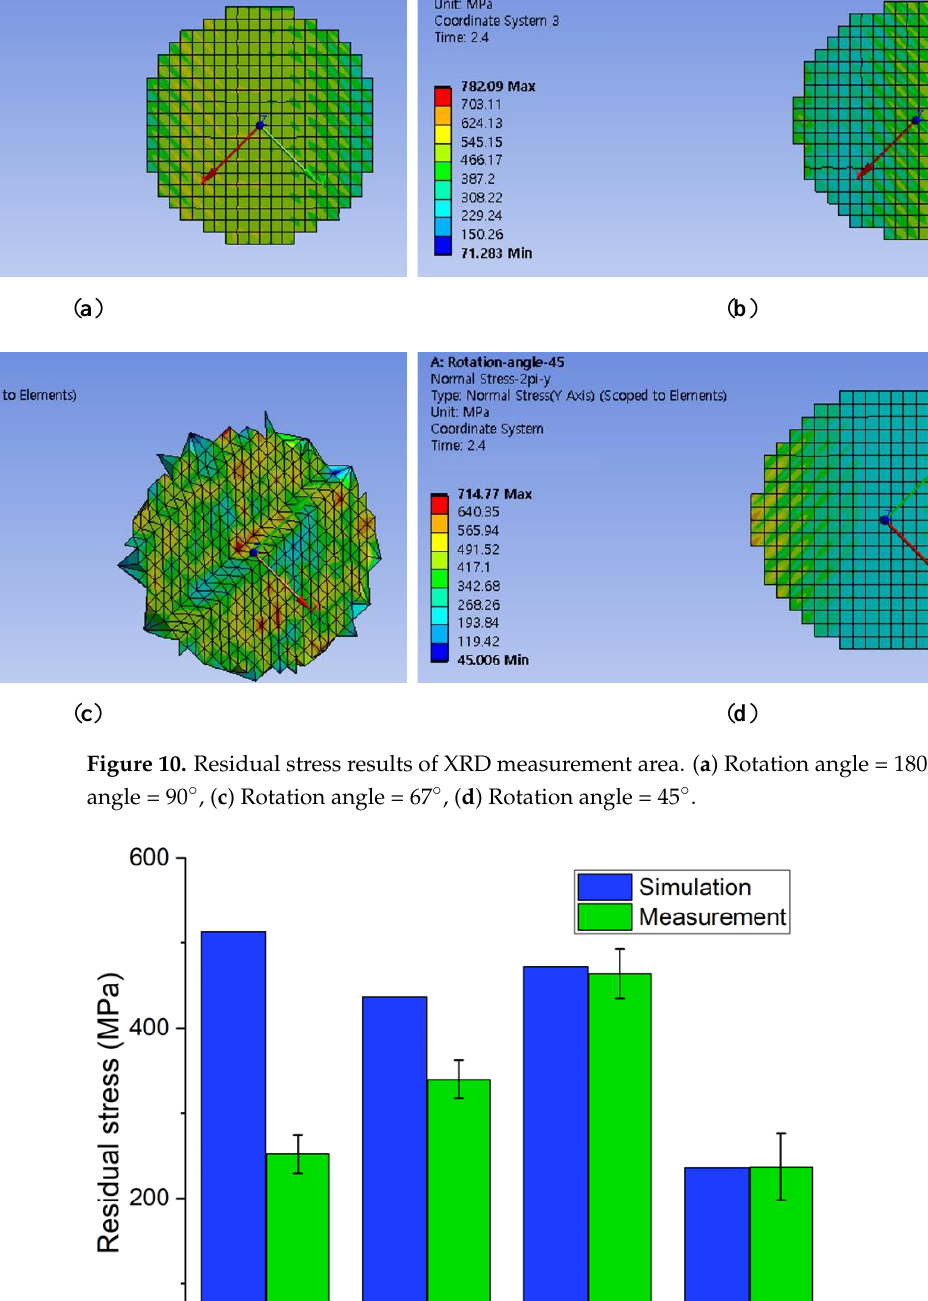
Table 3. Residual stress results.